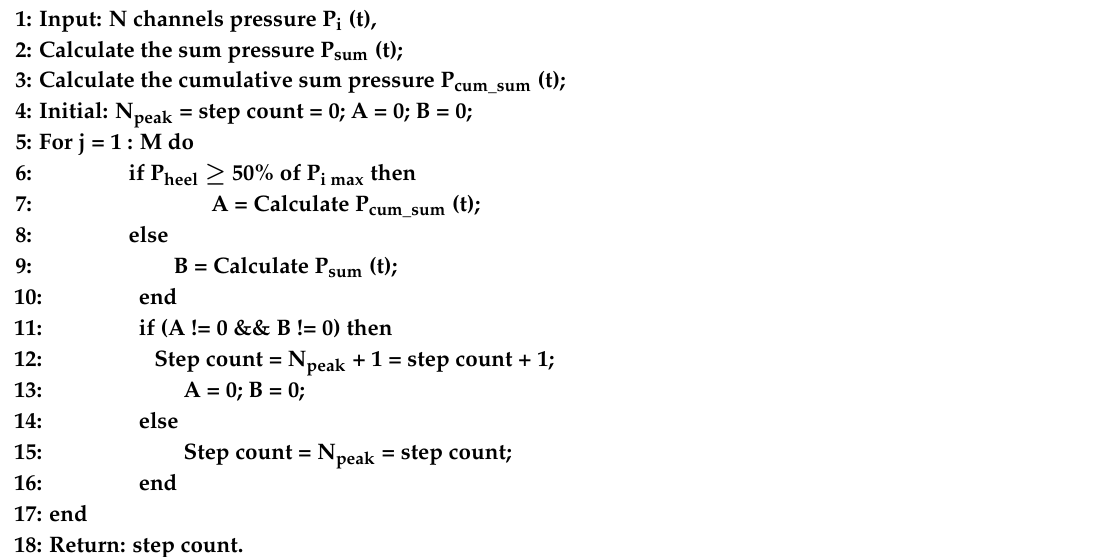
Algorithm 1: A step count algorithm using cumulative sum of all pressure